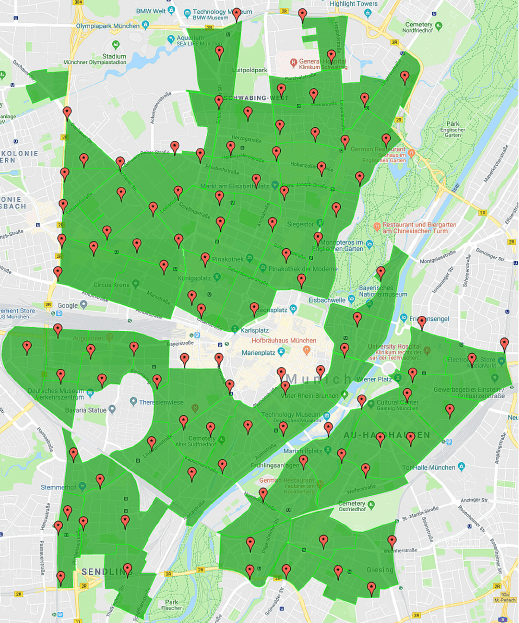
Figure 11. NSGA-II fleet placement solution which maximises user coverage in the city of Munich. Red pins are locations of the carsharing station. Green zones indicate the inner area of